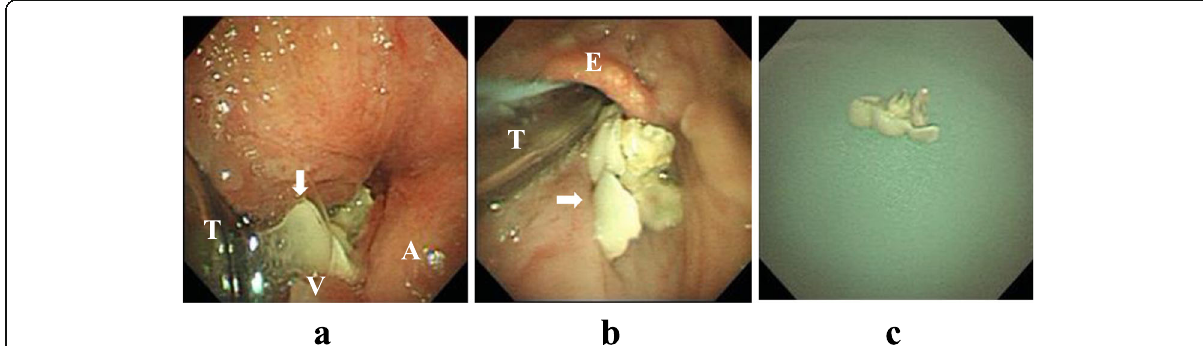
Fig. 3 Photographs taken with a bronchial fiber. a A foreign body (arrow) was located between the vocal cord (V) and the arytenoid cartilage (A) outside of the tracheal tube (T). b The foreign body during the removal procedure. The foreign body (arrow) was pulled up between the tracheal tube (T) and epiglottis (E). c A removed crown bridge, whose backing metal was covered with resin. It consisted of three connected teeth with a pointed